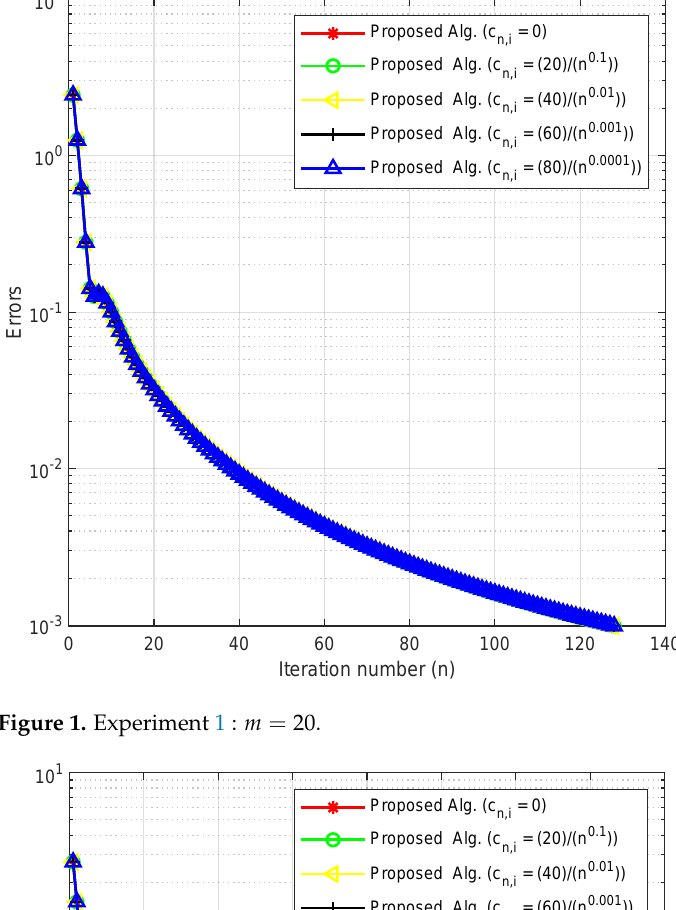
Figure 1. Experiment 1 : m = 20.